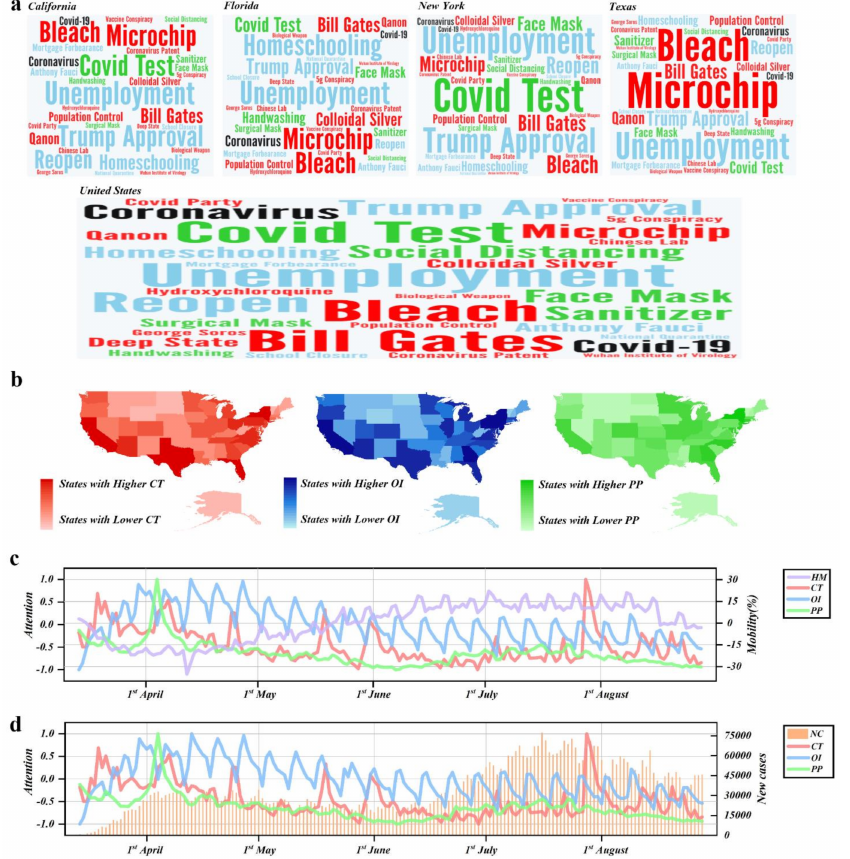
Figure 1. ( a ) The keyword clouds of the top search queries on Google in California, Florida, New York and Texas, as well as in the whole country. ( b ) The heat maps of the United States, based on the online attention on the selected keywords of the conspiracy theories and official information. ( c ) The co-movements between the summed human mobility, and the online attention to the keywords related to the coronavirus disease 2019 (COVID-19) conspiracy theories, official information and personal protection measures. ( d ) The co-movements between the reported COVID-19 cases and the online attention on the keywords related to COVID-19 conspiracy theories as well as to official information and personal protection measures. NC denotes the number of the reported COVID-19 cases, HM denotes the aggregate human mobility, CT denotes the combined online attention on the selected keywords that are related to COVID-19 conspiracy theories, OI denotes the combined online attention to the selected keywords that are related to official information, and PP denotes the combined online attention to the selected keywords that are related to personal protection